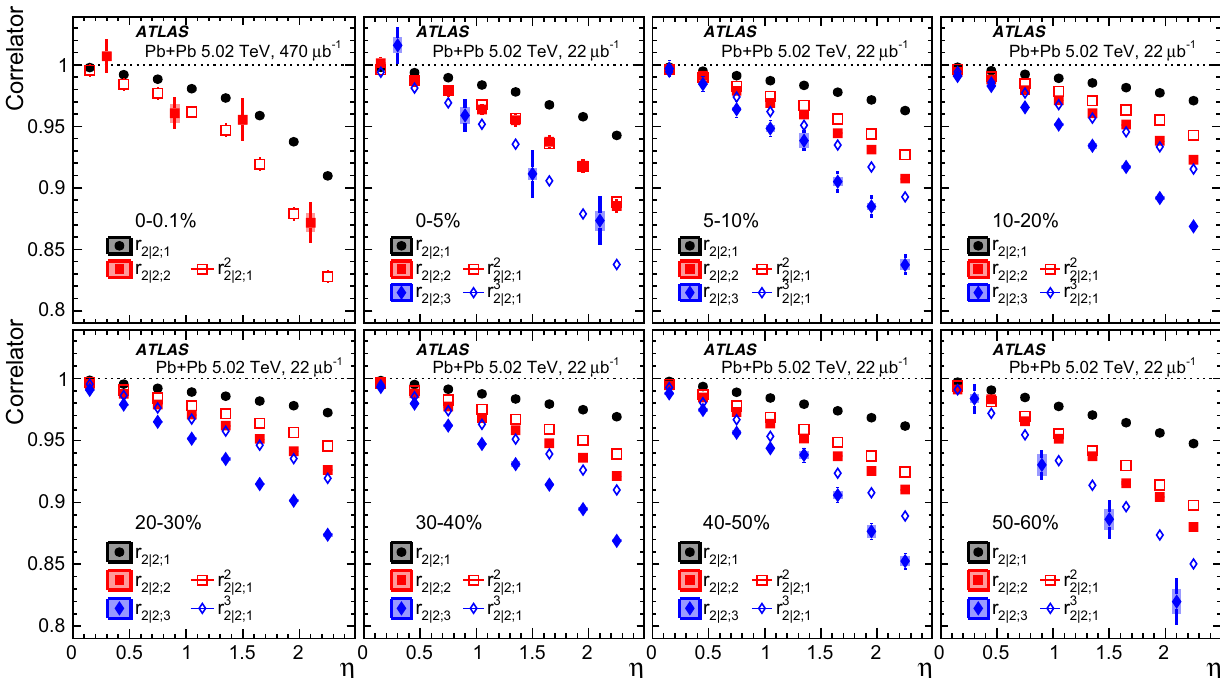
Fig. 15 The r 2 | 2 ; k for k = 1–3 compared with r k for k = 2–3 in various centrality intervals for Pb+Pb collisions at 5.02 TeV. The error bars 2 | 2 ; 1 and shaded boxes are statistical and systematic uncertainties, respectively. The data points for k = 2 or 3 in some centrality intervals are rebinned to reduce the uncertainty